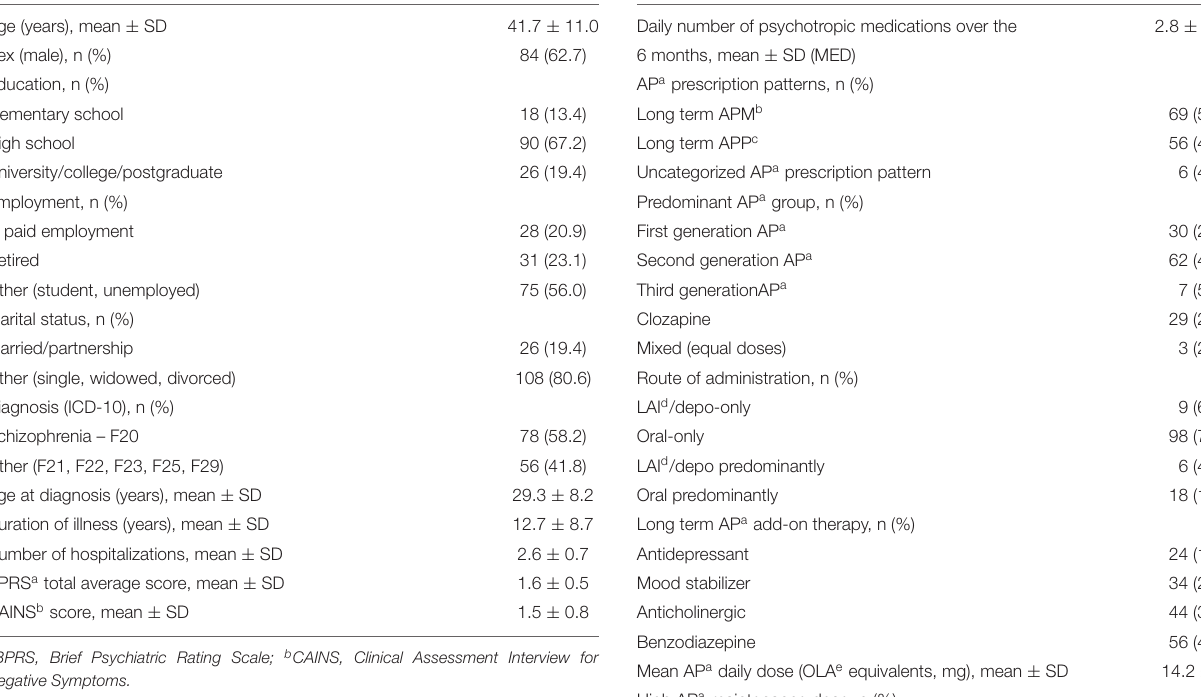
TABLE 1 | Sociodemographic and clinical characteristics of the sample. TABLE 2 | Psychotropic drug prescription patterns among the